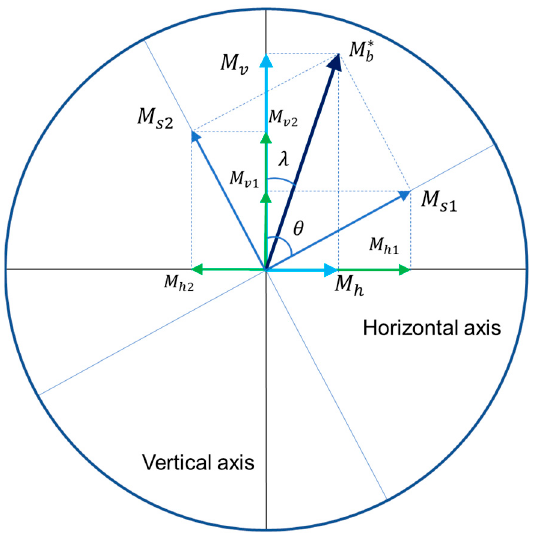
Figure 4. True dynamic bending moment measurement using two bridges of strain gauge.